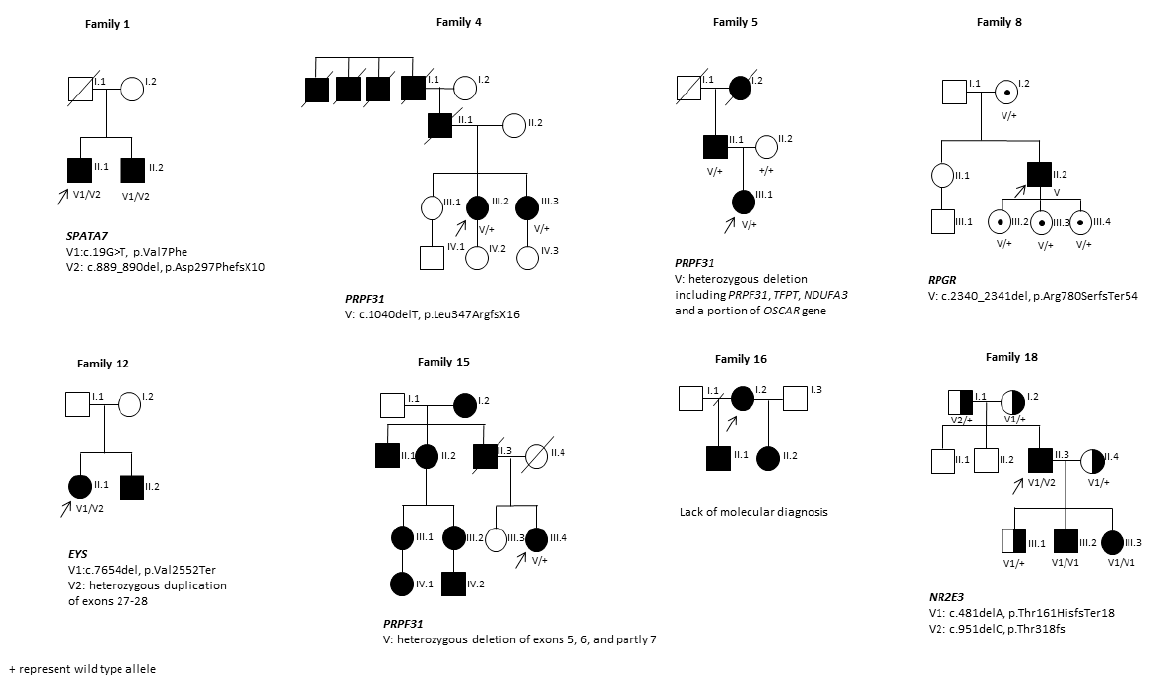
Figure 2. Pedigrees and segregation of the variants associated with the disease identified in familial RP cases. Genotypes are provided for all subjects available for molecular analysis. Identified pathogenic variants are placed below the pedigree. Wild-type variants are indicated with +, while disease-causing variants are indicated with V1 and V2.